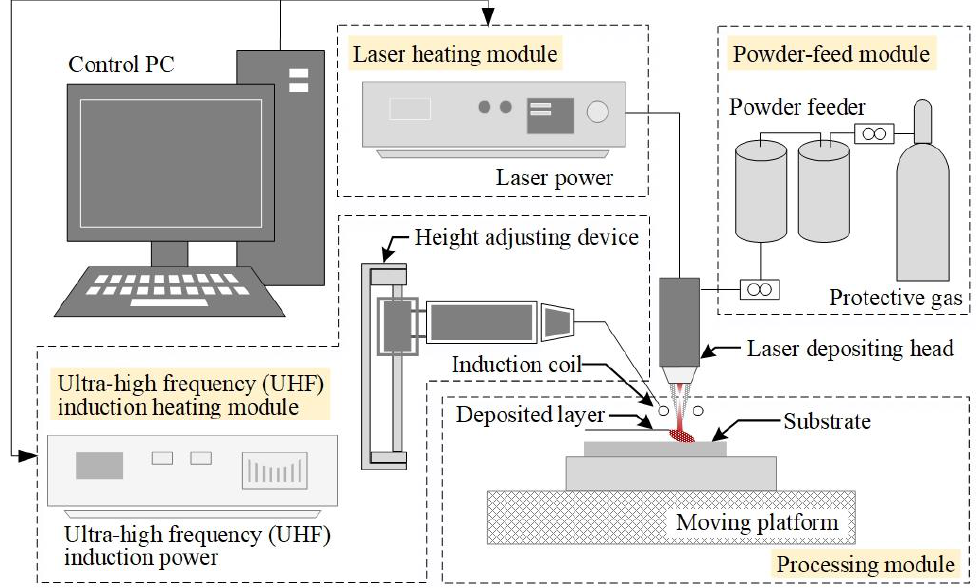
Figure 1. Schematic of laser-UHF induction hybrid deposition experimental platform.